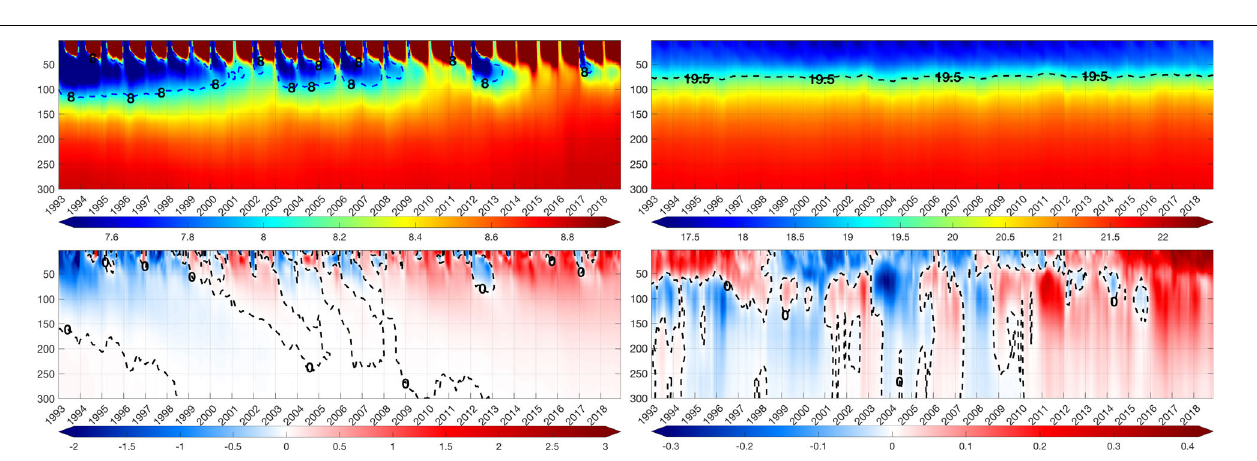
FIGURE 7 | Time evolution of the basin-averaged temperature in ◦ C computed from BS-REA in different layers: 0—25 m (top), 25–150 m (central), and 150–300 m (bottom). The dashed lines are the linear trends for the period 1993–2018 (black) and 2005–2018 (red), mean trend values are also reported in the figures (bottom right corner).